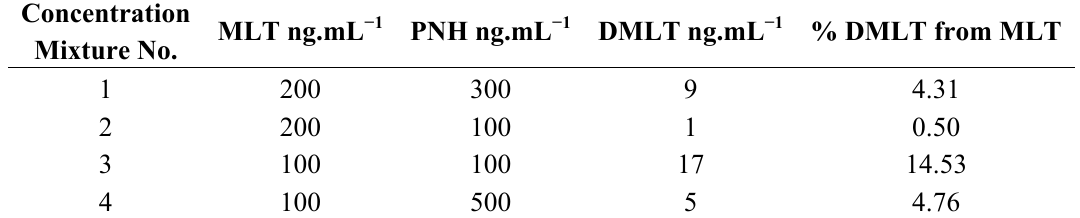
Table 1. The five level three factor experimental design of the training and validation set mixtures shown as concentrations of the mixture components in ng mL − 1